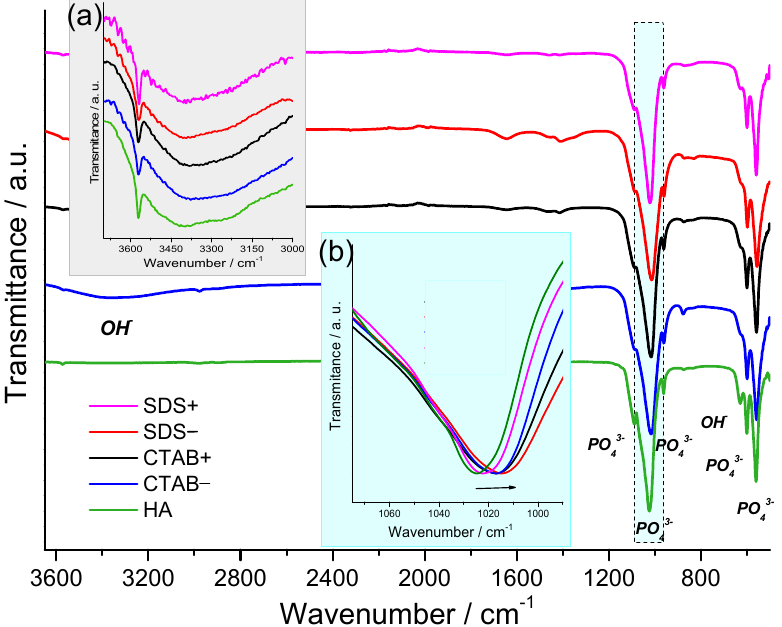
Figure 2. Infrared spectra of HA, CTAB − , CTAB+, SDS − , and SDS+ samples. Inset ( a ): the 3700–2000 cm − 1 region of infrared spectra of the HAp samples; inset ( b ): shift of the absorption band located around 1025 cm − 1 .